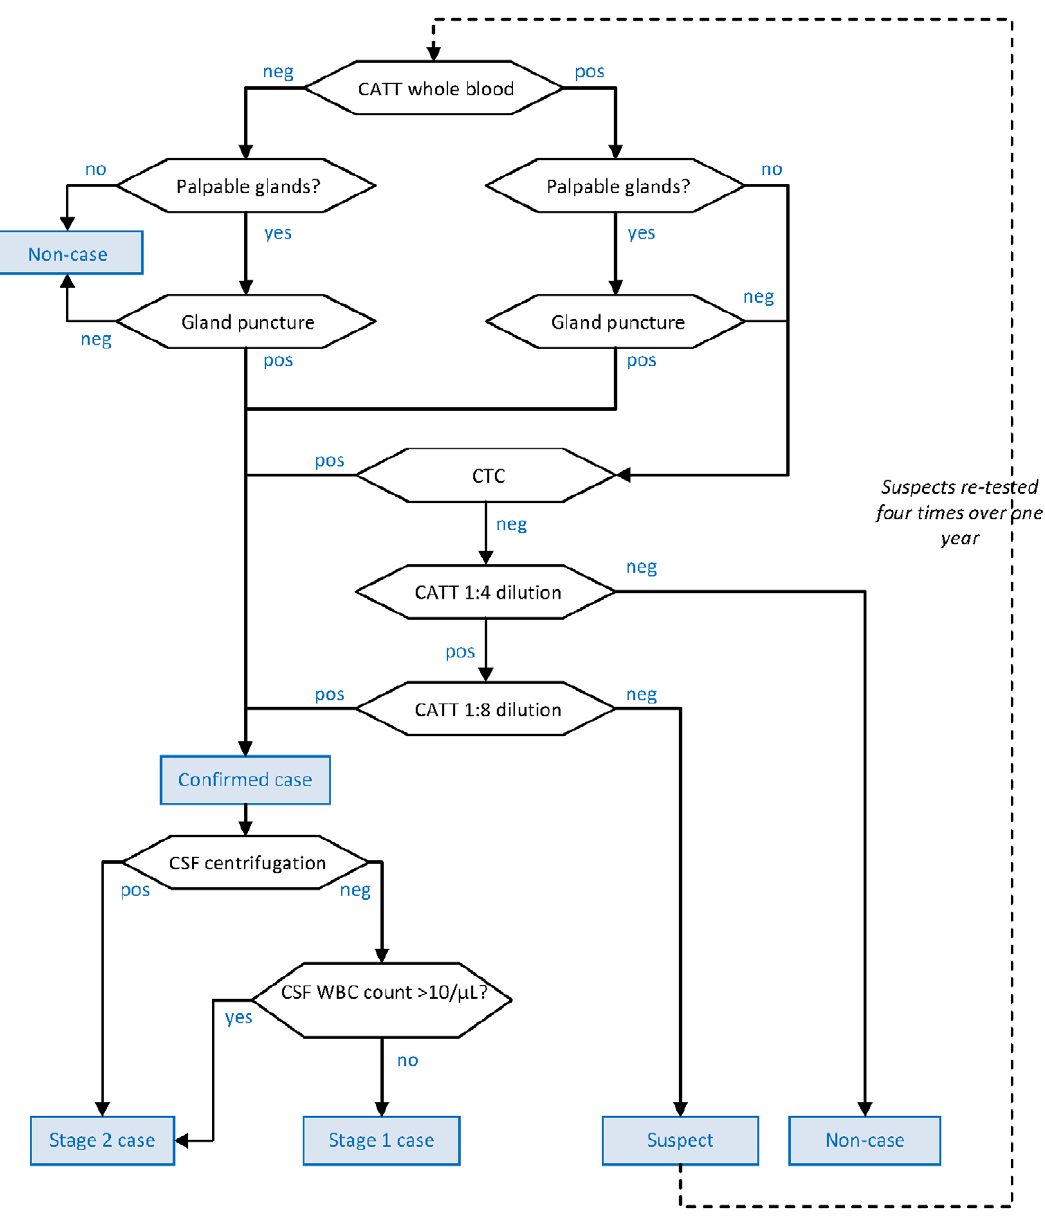
Figure 1. Diagnostic algorithm used in the Gamboma, Mossaka and Nkayi, Republic of Congo programmes. Hexagonal boxes indicate tests. Square, blue-shaded boxes indicate points at which a decision on the patient is